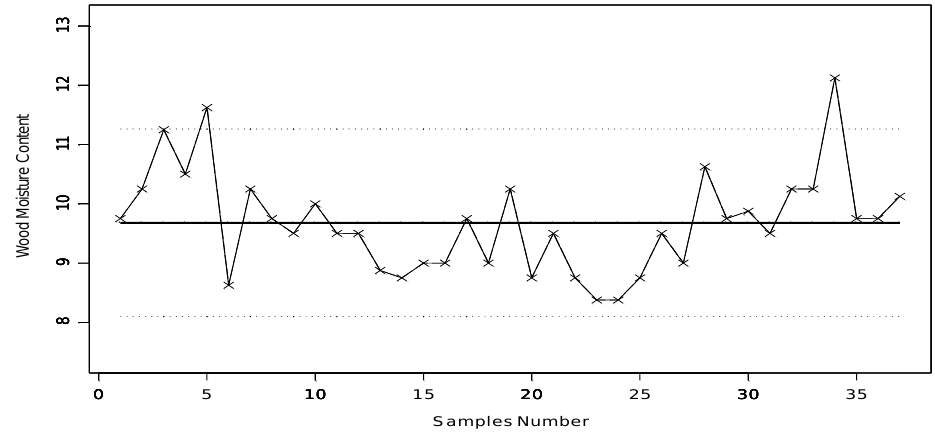
Fig. 2. X -bar control chart for wood moisture